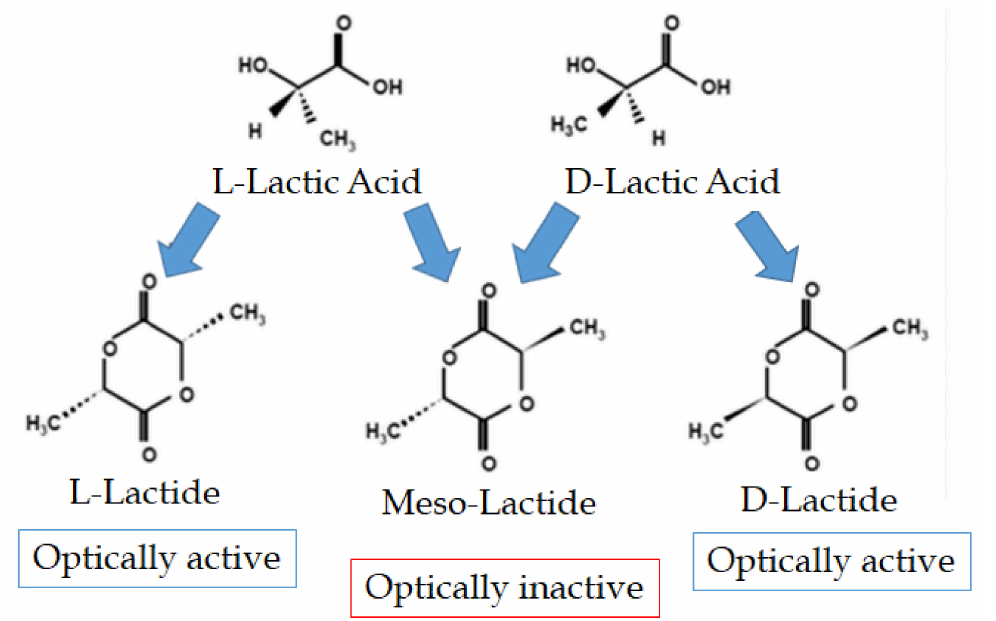
Figure 3. The stereoisomers of lactic acid and the resulting lactides, together with their optical activity adapted from